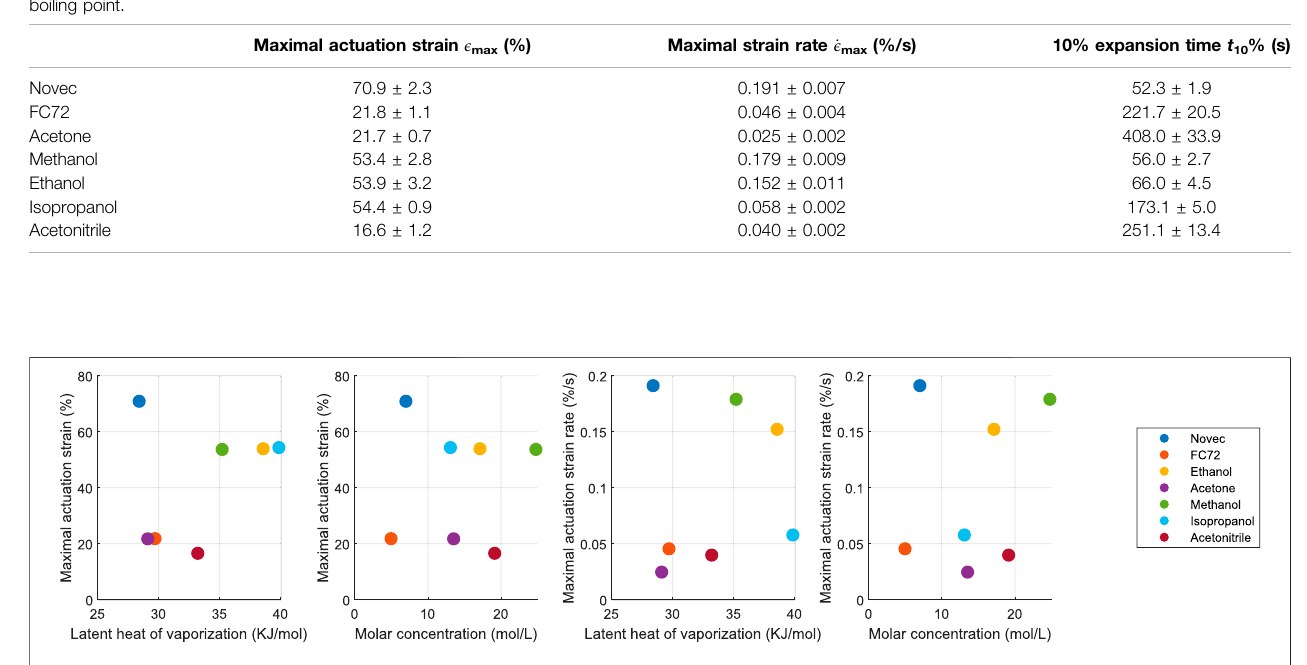
FIGURE 6 | In fl uence of the fl uid parameters on the maximal strain ϵ and a maximal strain rate _ ϵ . Experimental results.